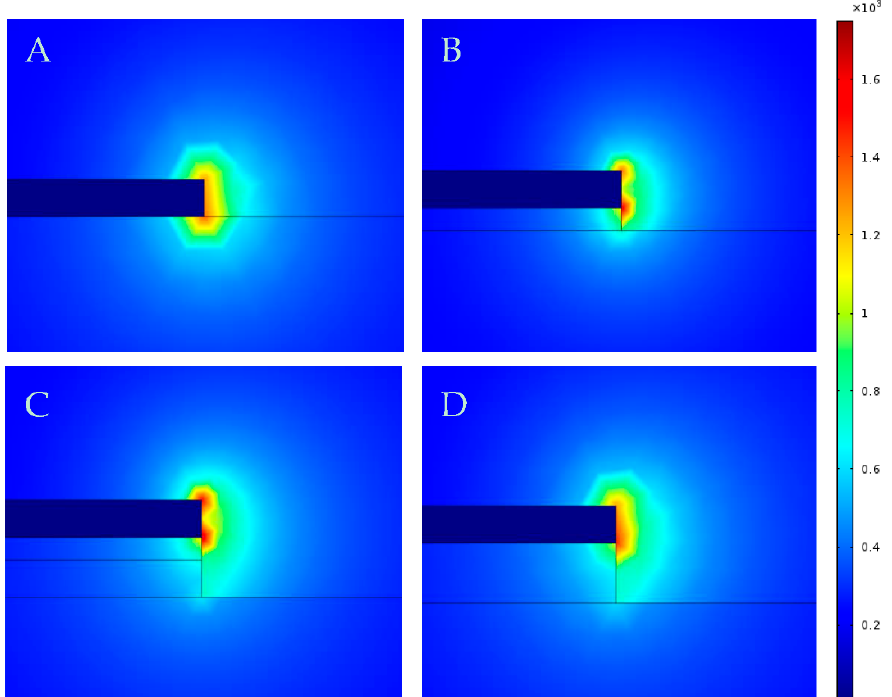
Figure 3. Electric field simulation results for lateral PCSS design showing field enhancements when